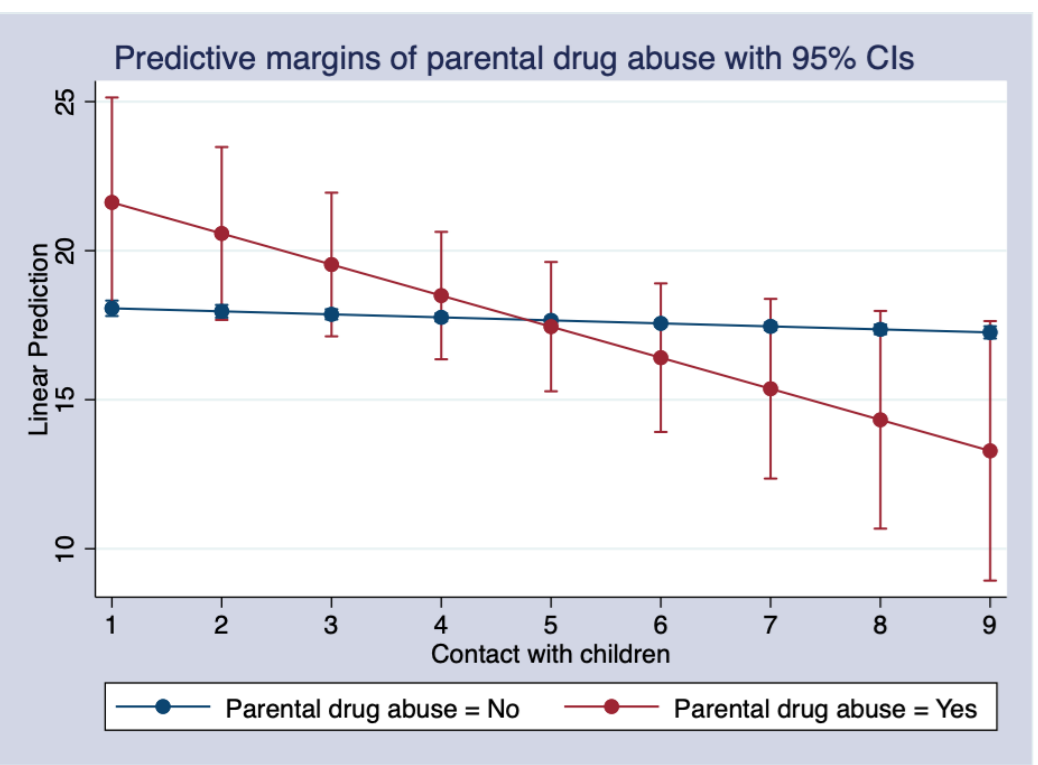
Figure 2. The marginal effects of contact with children on depression and parental drug abuse.